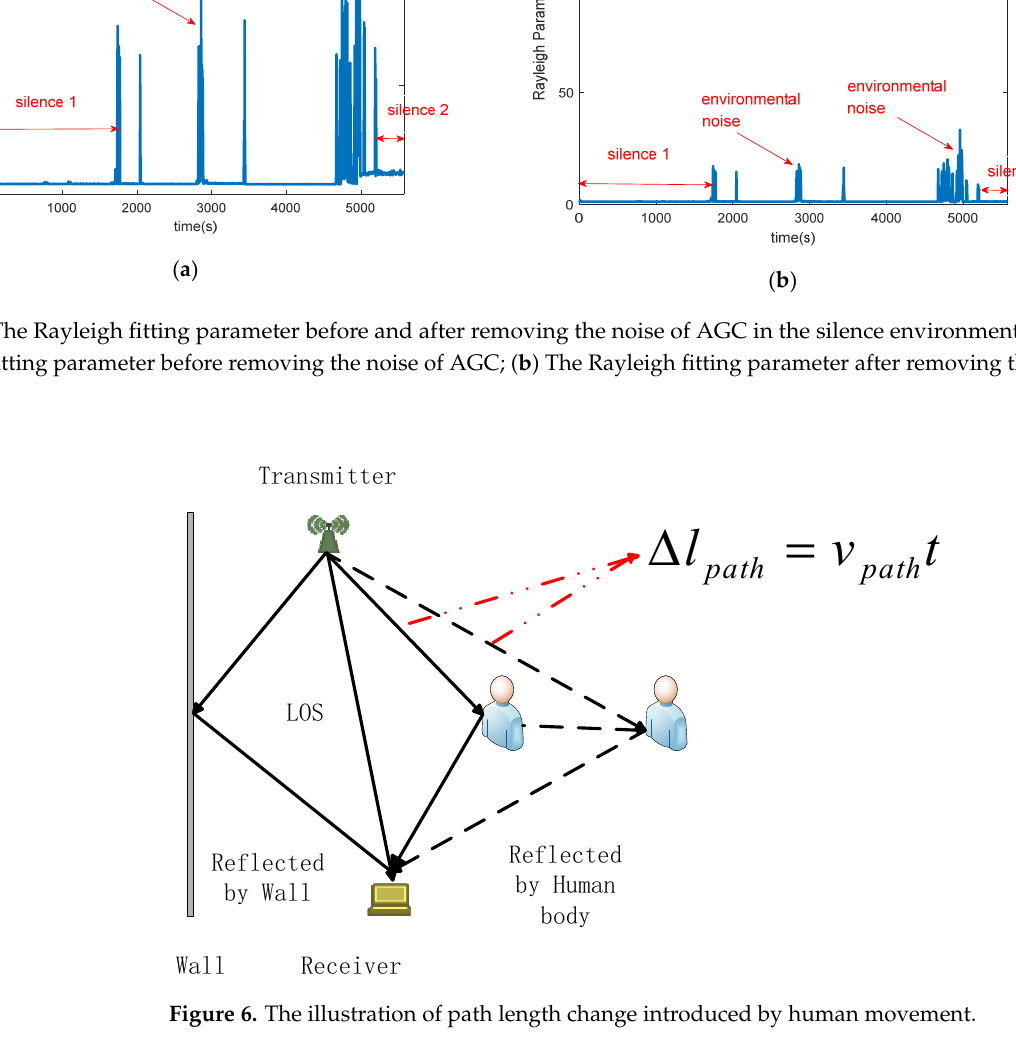
Figure 6. The illustration of path length change introduced by human movement.